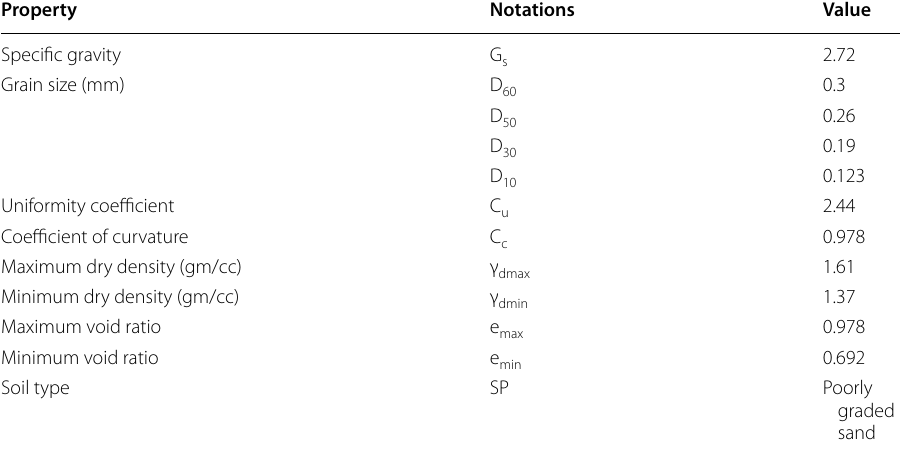
Table 1 Physical properties of Digha sand